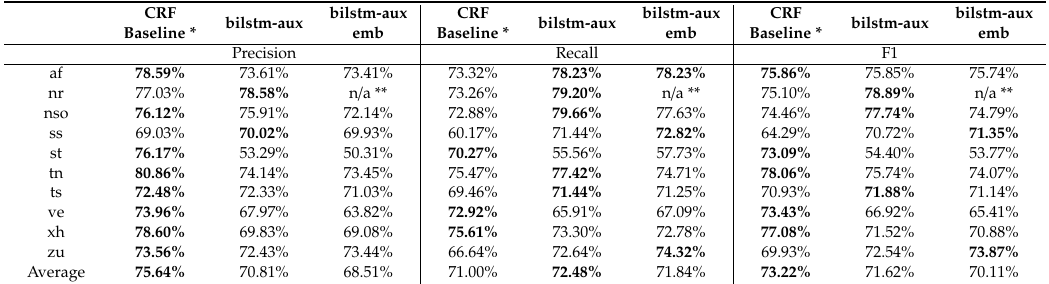
Table 6. NER F1-scores; numerically highest precision, recall and F1 scores per language are in bold font.